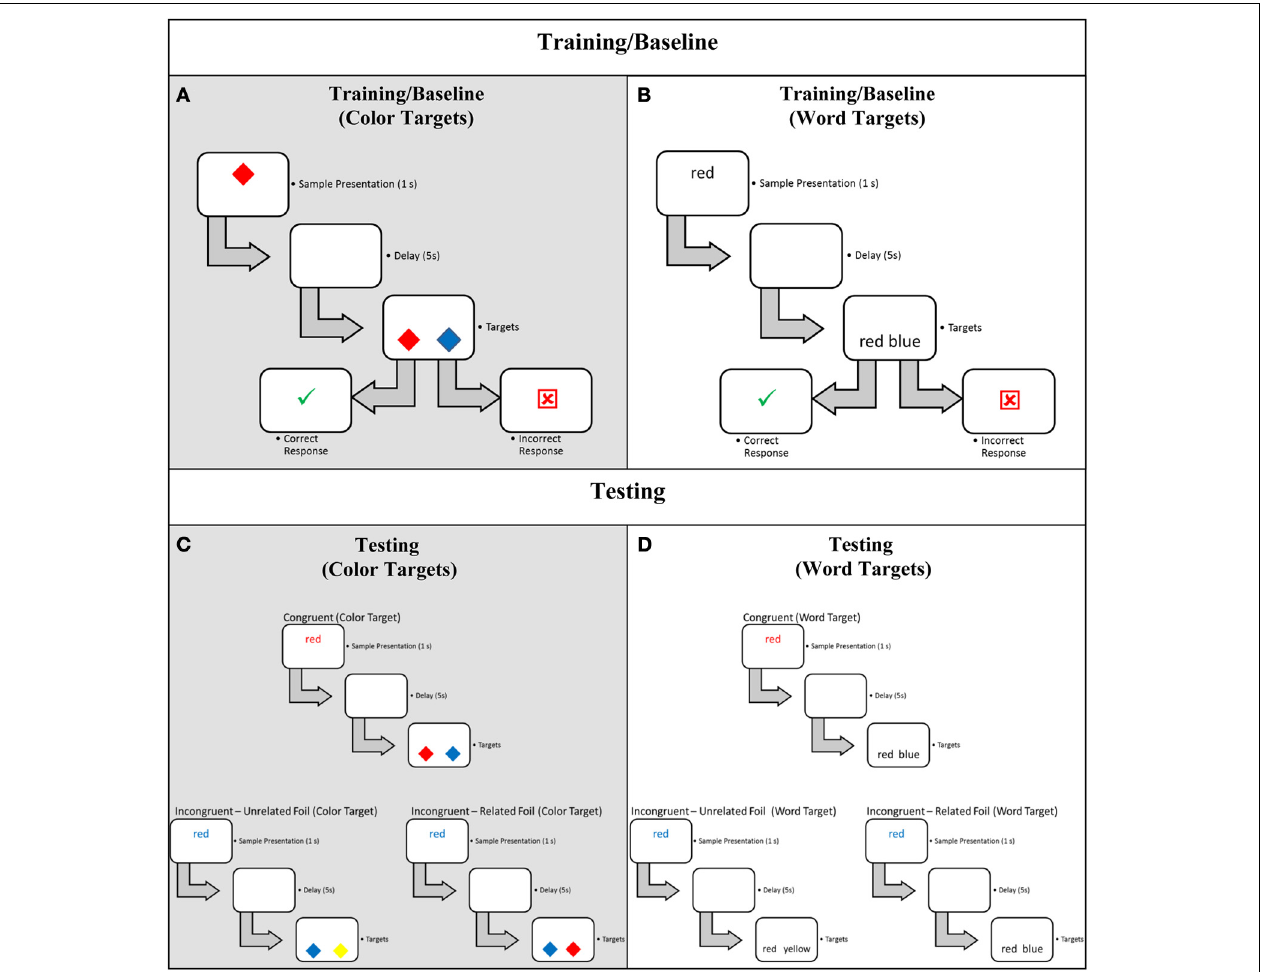
FIGURE 1 | Sample Trial Types and trial structures for the Delayed Match-to-Sample task. One sample Baseline/Training trial is illustrated for Color Targets (A) and Word Targets (B) , and one sample Congruent, Incongruent—Unrelated Foil, and Incongruent—Related Foil trial is